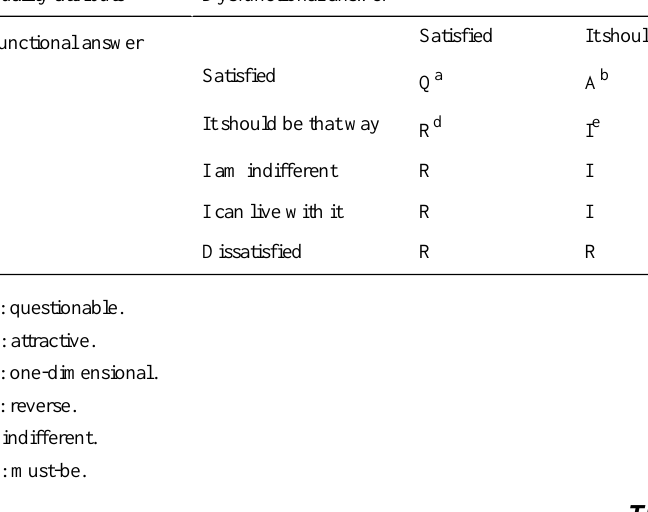
Dysfunctional answerQuality